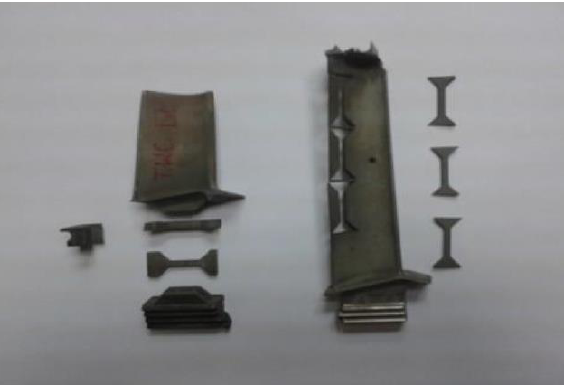
Figure 7. View of specimens cut out (using the electro-discharge method) of a material of the LPT blade and view of specimens for static tensile testing cut out of the material of the HPT blade and LPT blade.